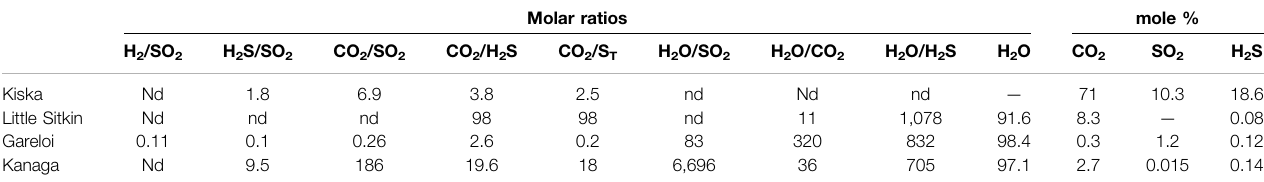
TABLE 3 | Multi GAS data collected in September